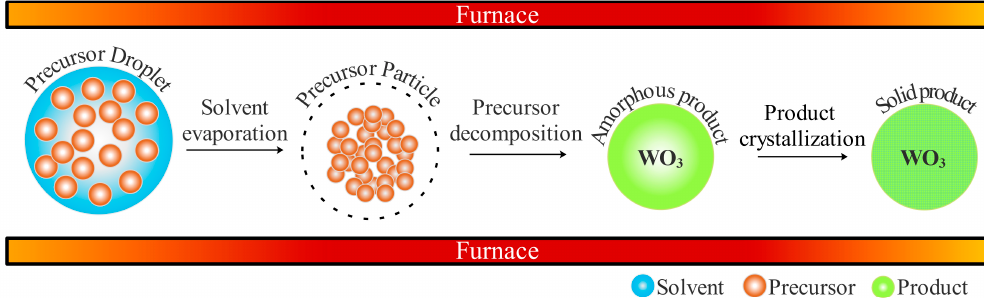
Figure 3. The mechanism of the formation of WO 3 particles in the spray pyrolysis method.